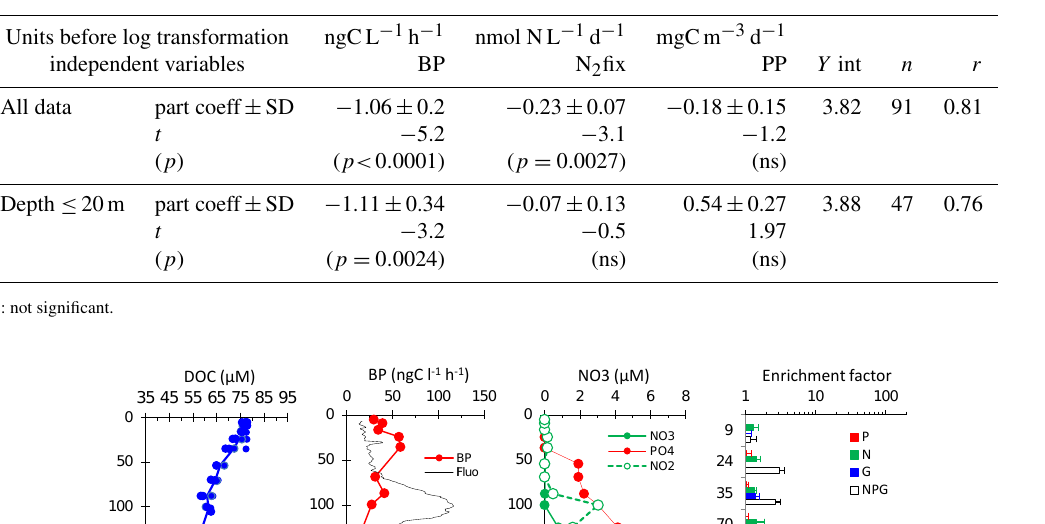
Table 4. Results of multiple regressions log T DIP = f (log BP, log PP, log N 2 fix). The unit of T DIP before log transformation is h . Y int is the intercept with the Y axis. Partial coefficient of regression (part coeff), t value ( t ) and probability of the regression to be significant ( p ).